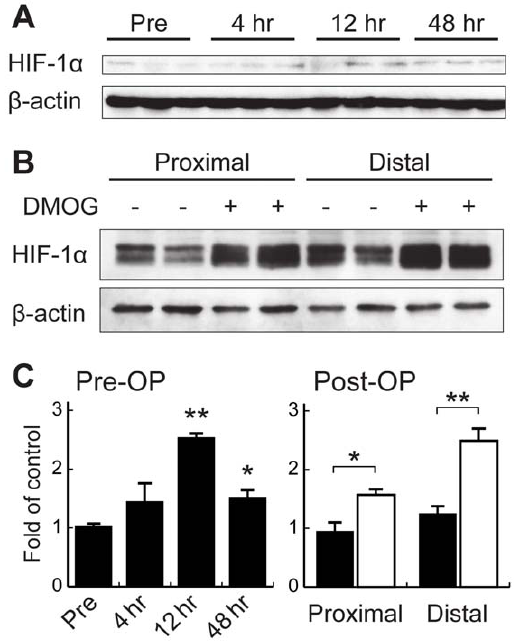
Figure 3. Expression of HIF-1 a protein in the skin after intraperitoneal administration of DMOG. Immunoblot analyses were performed on tissue lysates from dorsal skin taken preoperatively (A and C) and from the proximal and distal parts of the skin flaps on postoperative day 1 (B and C). In panel A and C, HIF-1 a protein expression in the skin is shown before (Pre) and at 4, 12, and 48 hours after DMOG treatment. * P , 0.05 and ** P , 0.01 compared with Pre. In panel B and C, * P , 0.05 and ** P , 0.01 compared with the untreated mice. b -Actin was used as a loading control.